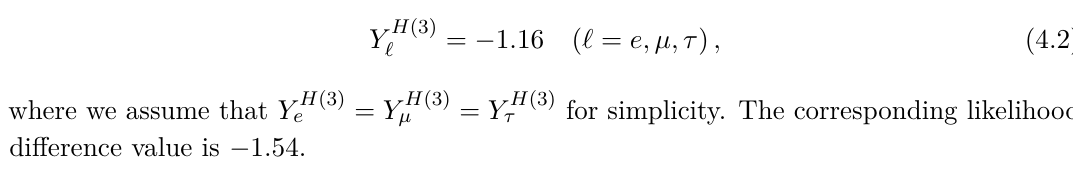
Figure 8. Potential effect of the Φ 2 ,e leptoquark on ( g − 2) e via the couplings Y LR show the preferred parameter space regions for the two contradicting SM determinations of ( g − 2) based on Rb (blue) and Cs (orange) atoms. In the preferred parameter space regions, sizeable loop corrections to the electron mass are generated, and the EDM constraint places strong limits on the complex phases of these